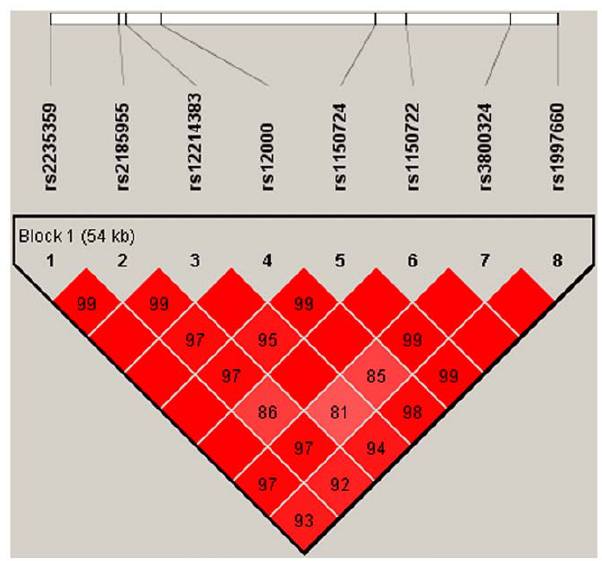
Figure 1. The linkage disequilibrium (LD) block structure consisted of the eight SNPs located in ZKSCAN4 , NKAPL , and PGBD1 genes. The LD pattern was derived from the combined group (i.e., both case and healthy control subjects). The LD block was defined by a D 9 value threshold of 0.8. The color scale ranges from red to white (color intensity decreases with decreasing D 9 value). This locus was identified as one block, and the plot was generated by Haploview.